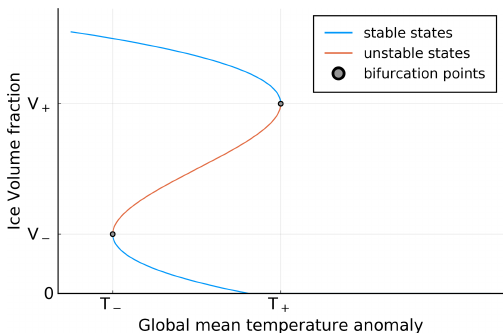
Figure 4. Ice sheet steady states for model defined in Eqs. (38) and